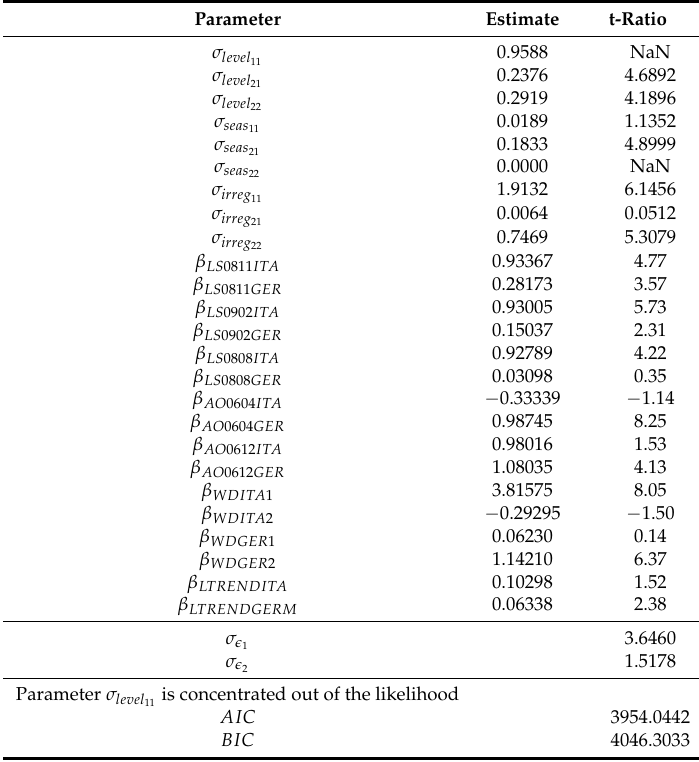
Table A11. Endogenous variables: IPI t capital goods LCVDE t in